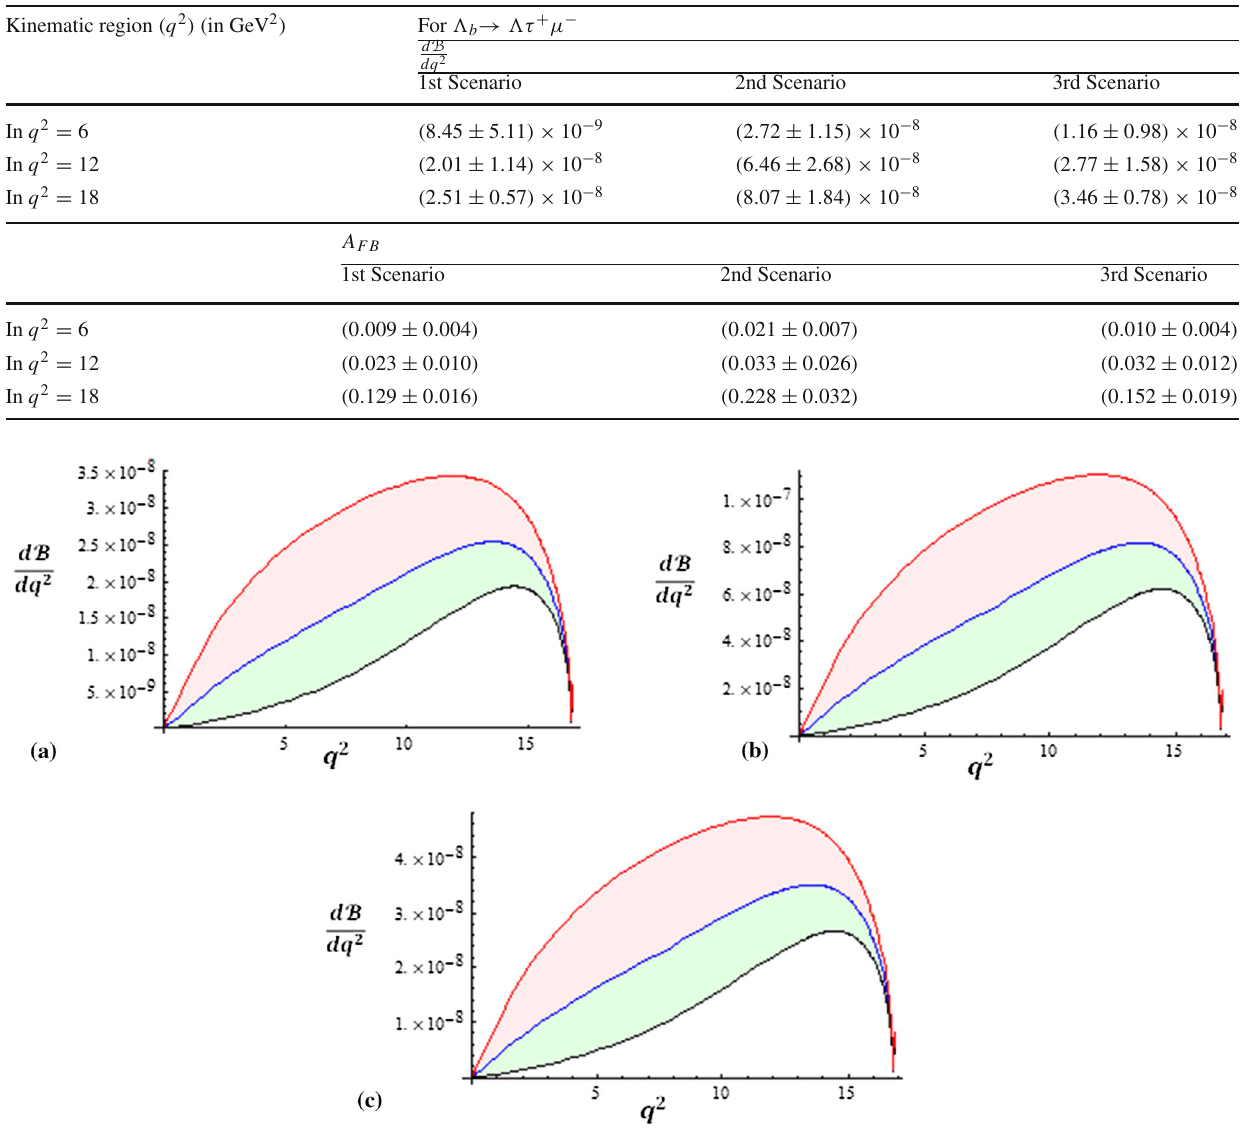
Fig. 5 Variation of differential branching ratio for (cid:2) b → (cid:2)τ + μ − within allowed kinematic region of q 2 using the bound of NP couplings for a scenario 1, b scenario 2 and c scenario 3